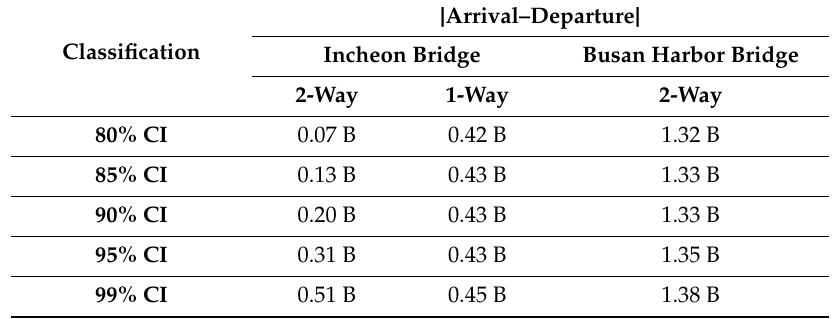
Table 14. Data for the distance di ff erence divided by the ship’s maximum breadth for two bridges across